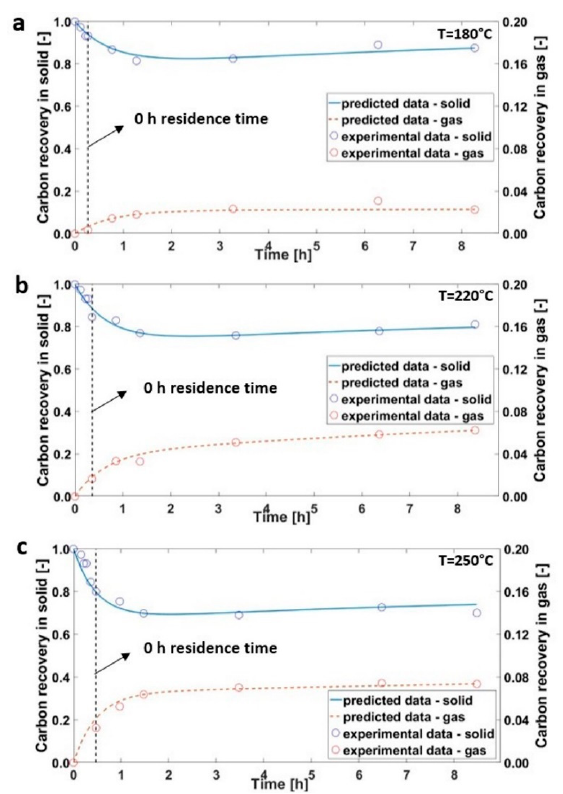
Energies 2019 , 12 , 516 11 of 22